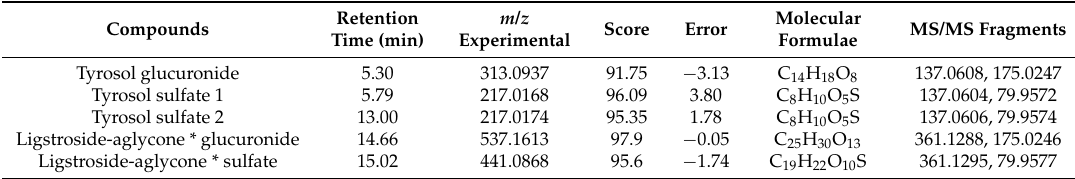
Table 2. Targeted analysis: metabolites detected in the urine and plasma samples of the volunteers following the consumption of the Fraxinus angustifolia extract. All the metabolites were present at low